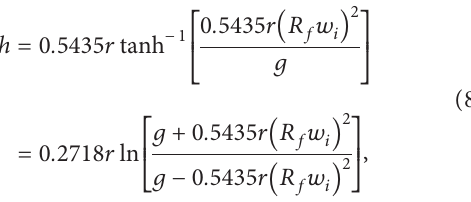
Harmonic base acceleration Random load applied to primary structure